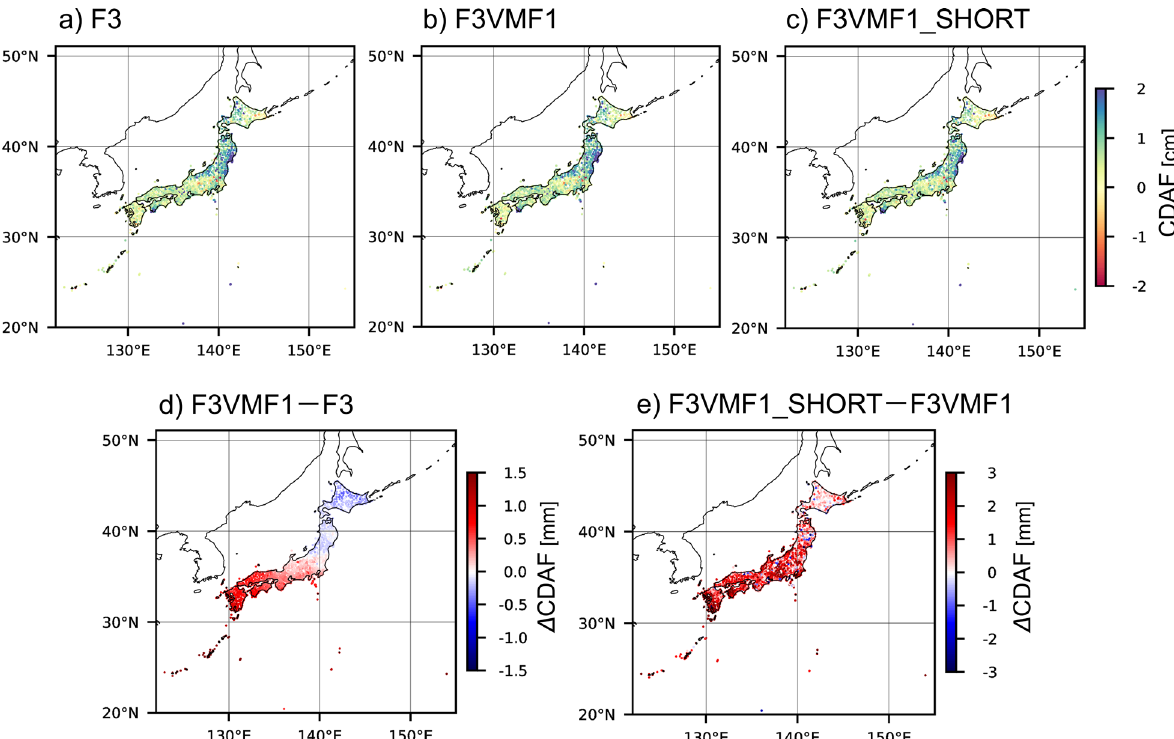
Fig. 12 Same as Fig. 10, but for CDAF. Note that color scales in d and e are